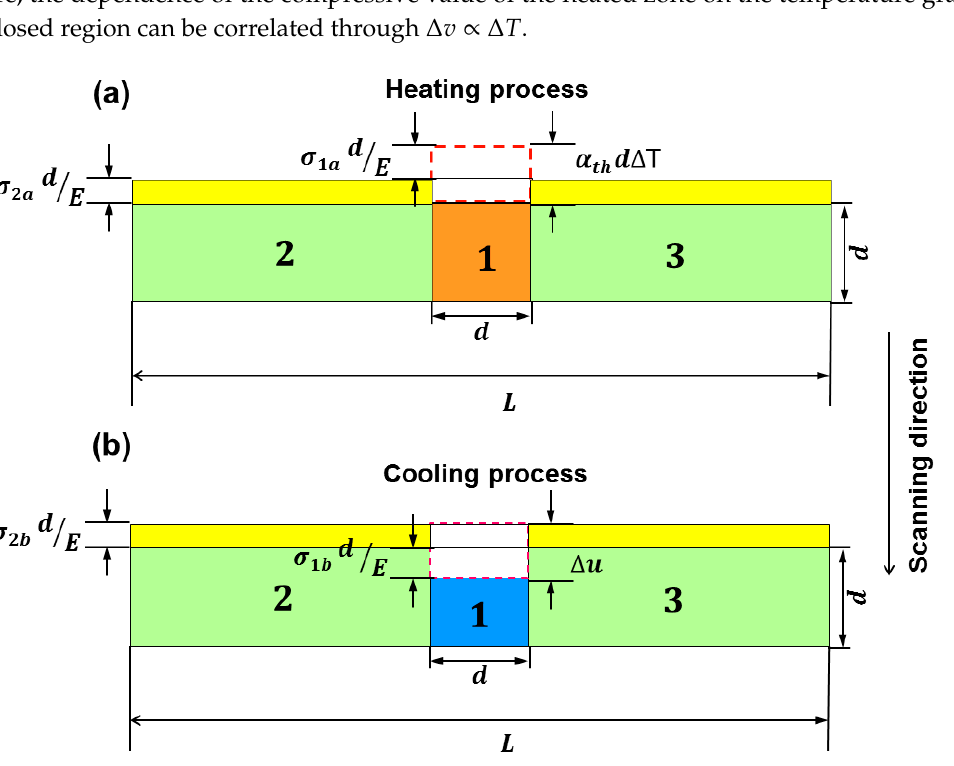
Figure 10. Schematic diagram of heating deformation of the previous layer during laser scanning of the current layer.